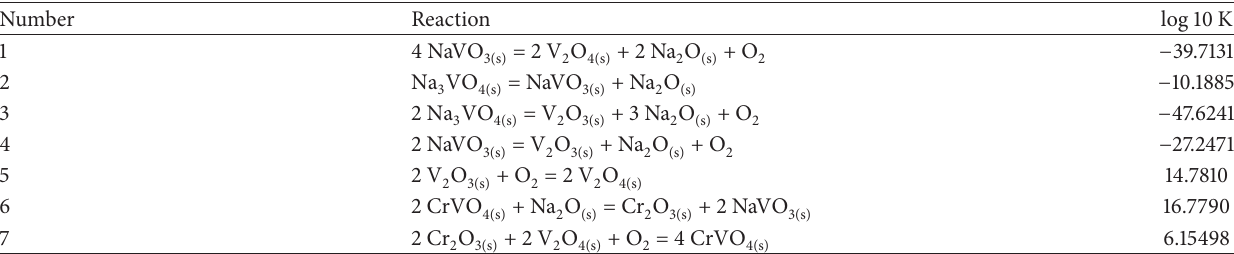
Table 2: Chemical reactions and equilibrium constants for the Cr-Na-V-O system at 700 ∘ C.